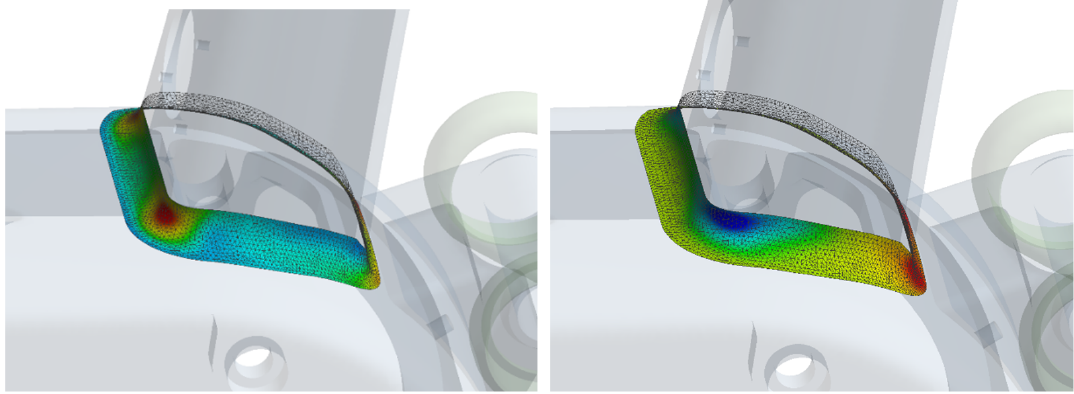
Figure 6. Area of expected failure.